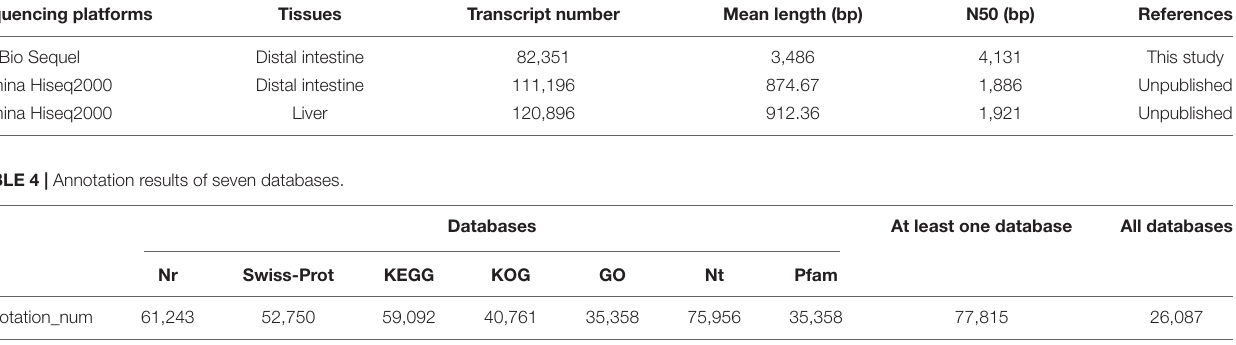
TABLE 3 | Comparison of unigenes from the PacBio and Illumina sequencing platforms of the pearl gentian grouper. Sequencing platforms